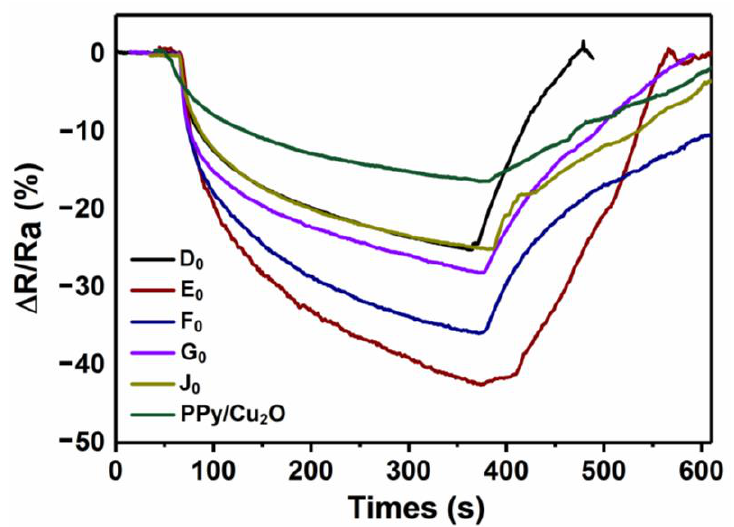
Figure 9. The gas sensing response curves of rGO/PPy/Cu 2 O nanocomposites with different mass ratios of GO to PPy/Cu 2 O nanowires to the NO 2 flow of 50 ppm (D 0 : 0.08; E 0 : 0.1; F 0 : 0.12; G 0 : 0.15; and J 0 : 0.20).